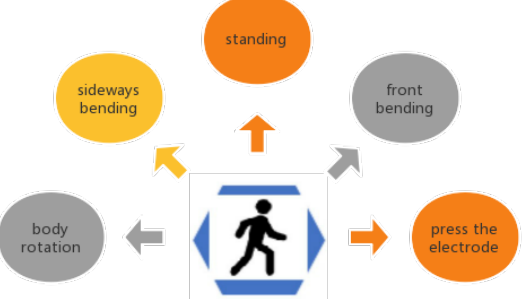
Figure 7. Typical motion types to trigger the motion artifacts. Table 1. Different motion artifacts.